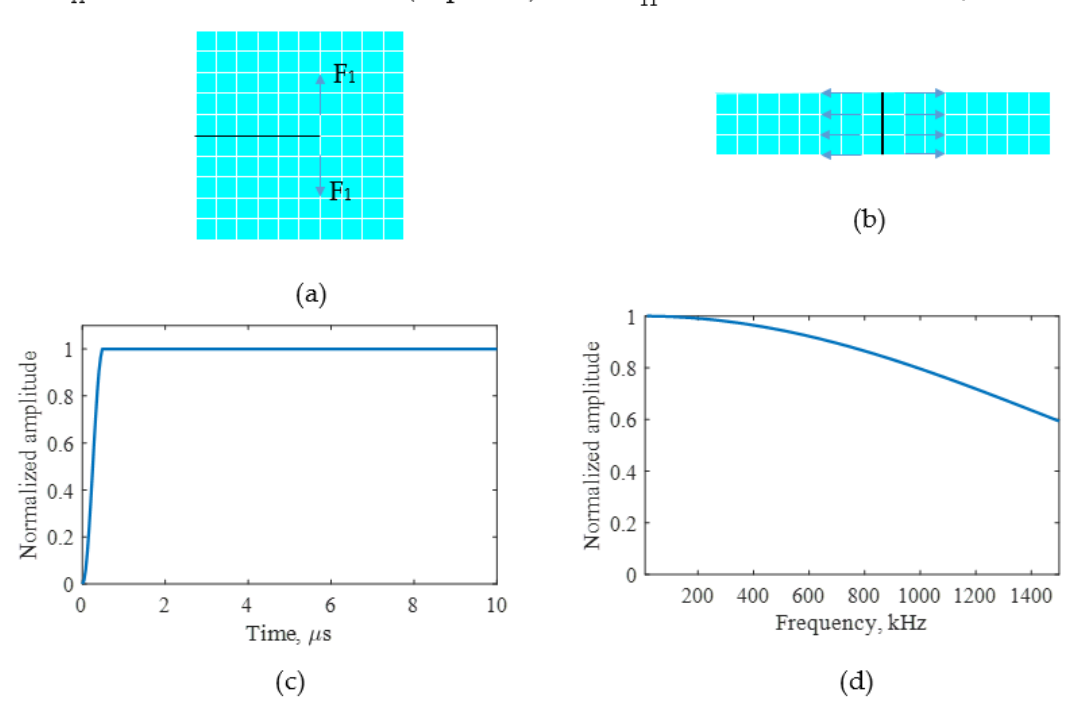
Figure 2. Simplified FEM model using the symmetric boundary condition for the AE simulation.